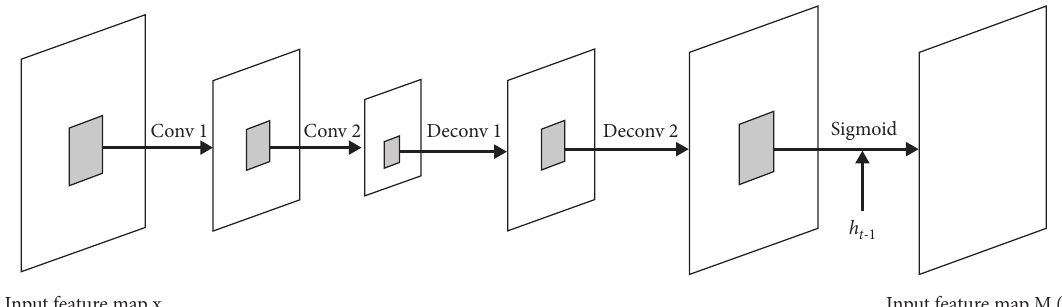
Figure 2: Branch structure of